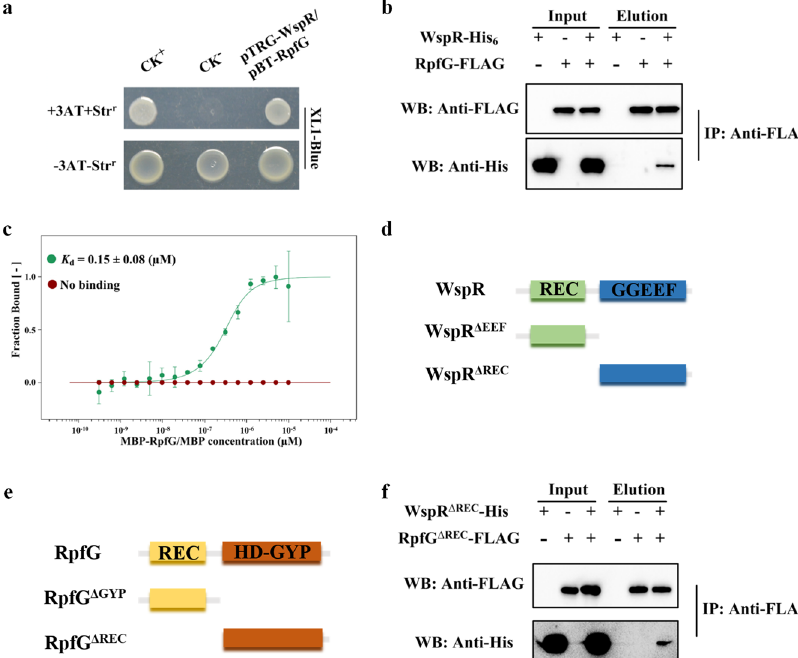
Fig. 4 Physical interaction between WspR with RpfG. a E. coli-based B2H assay showing that WspR interacts with RpfG. CK + , positive control (pBT-GacS and pTRG-GacS) and CK − , negative control (empty vector of pBT and pTRG). WspR, pTRG-WspR. RpfG, pBT-RpfG. − 3AT-Str r and + 3AT + Str r represent strains grown on LB-based non-selective medium and minimal medium (M9)-based selective medium respectively. b Pull-down assay con fi rming the interaction of WspR-His with RpfG-FLAG. The IP assay was performed using anti-FLAG antibody. Western blotting was carried out using anti-FLAG and anti-His antibodies. c Microscale thermophoresis (MST) measurement of binding af fi nity: green trace, WspR-His and MBP-RpfG ( K d = 0.15 μ M); red trace, WspR-His and MBP (no binding). d Schematic map of the full-length WspR and their truncations (WspR Δ REC and WspR Δ EEF ). e Schematic map of the full-length RpfG and their truncations (RpfG Δ REC and RpfG Δ GYP ). f Pull-down assay con fi rming the interactions between the GGDEF domains of WspR (WspR Δ REC ) and the HD-GYP domain of RpfG (RpfG Δ REC ). All blots derive from the same experiment and that they were processed in